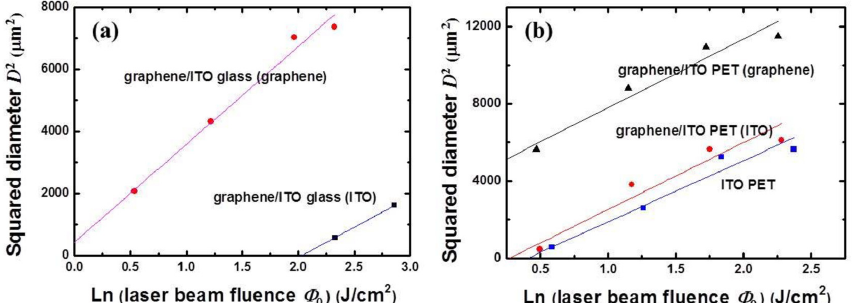
Figure 2. Squared laser-patterned diameters (line widths) of ITO single layer and graphene / ITO double layer on ( a ) glass, where the solid red circles and black squares indicate the data for graphene and ITO layers on ITO-coated glass substrate, respectively, and ( b ) PET substrates, where the solid black triangles and red circles indicate the data for graphene and ITO layers on ITO-coated PET substrate, respectively, the blue squares are the ITO single layer on PET substrate. Each colored line shows a linear fit of the data. The laser-ablated line widths of Figure 2a,b were obtained from Figures 3 and 4, respectively.